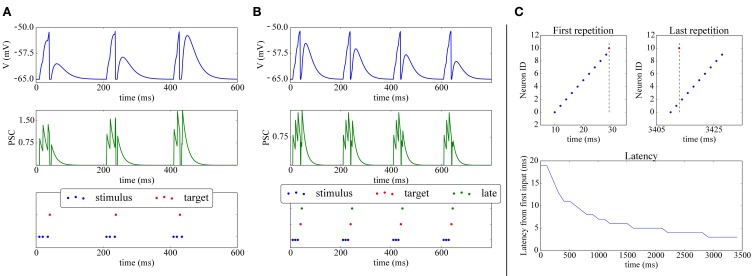
Shift of post-synaptic firing onset via STDP. (A) Potentiation: The spike raster plot (bottom) shows that at the beginning of the stimulation 3 input spikes (blue) are needed to make the target neuron (red) fire; after 400ms, potentiation has made the synapse strong enough so that the post-synaptic neuron fires after only 2 spikes. This is also visible in the membrane potential (top) and post-synaptic currents (PSC; middle). (B) Depression: (bottom) The green neuron is made to spike consistently after the target (red) neuron, hence its weight gets depressed, as can be observed by its decreasing contribution in the membrane potential (top) and PSC (middle). (C) Reduced spike latency: at the beginning of the simulation (upper-left panel) 10 spikes from 10 different input neurons (blue) are needed to make the post-synaptic (red) neuron fire; after repeated stimulation (upper-right-panel), potentiation via STDP makes the red neuron fire already after 2 spikes, hence firing closer to the pattern's start, which is also shown by the latency plot (bottom panel).